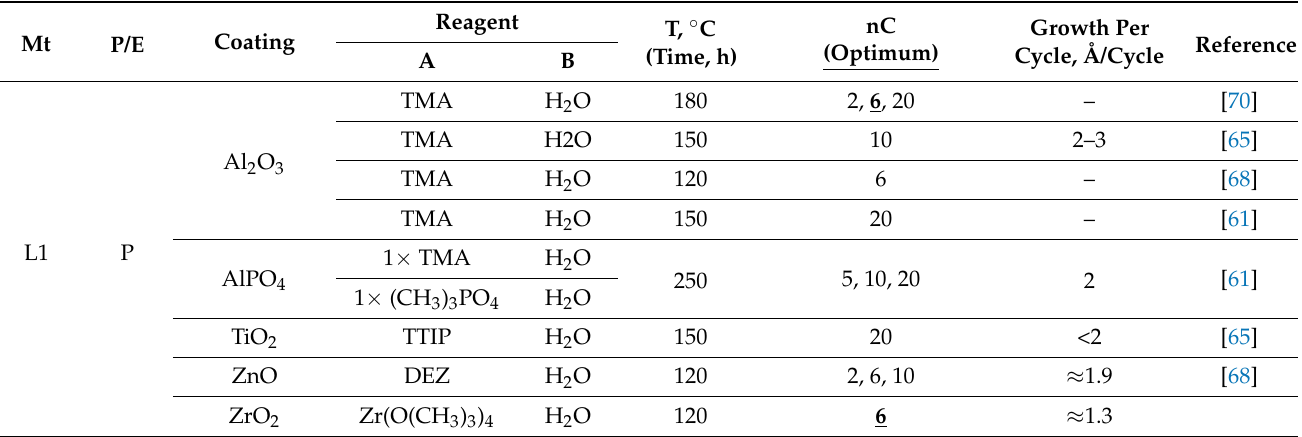
Table 5. Main parameters of LMR